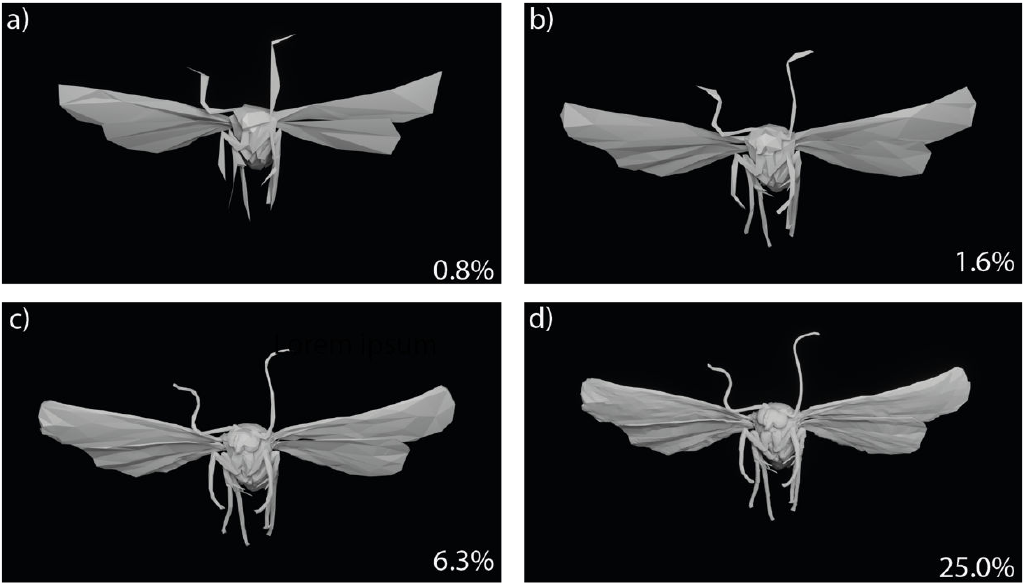
Figure 3. Depiction of four models representing the range of decimations modelled in this study: ( a ) 0.8%, ( b ) 1.6%, ( c ) 6.3% and ( d ) 25.0%. The percentage indicates the percentage of plates that comprises each model compared to the full resolution